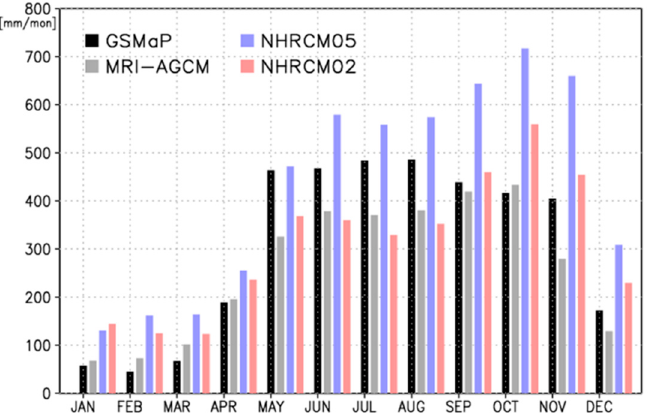
Figure 5. Seasonal changes of 20-year mean monthly precipitation in three simulations against observations.